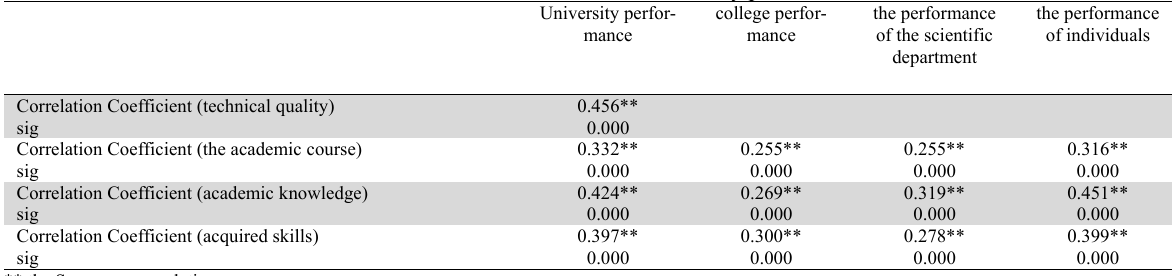
Correlation coefficient between the academic course dimension and university performance and its dimensions